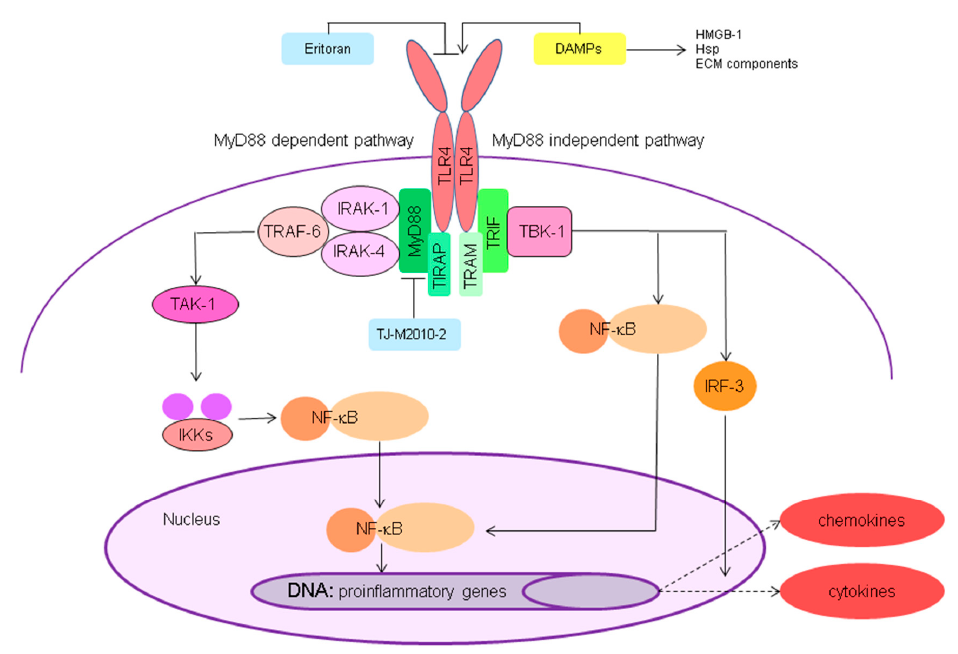
Figure 6. Toll-like receptor 4 signalling. Activation of toll-like receptor 4 (TLR4) by danger associated molecular patterns (DAMPs), like high mobility group box-1 (HMGB-1), heat shock proteins (hsp) and extracellular matrix (ECM) components, leads to downstream signalling via the MyD88 (Myeloid di ff erentiation primary-response protein 88) dependent and MyD88 independent pathway. The MyD88-dependent pathway in which MyD88 and TIRAP (toll-interleukin 1 receptor (TIR) domain containing adaptor protein) or MyD88 adapter-like (Mal) recruits and activates members of the IL-1 receptor-associated kinase (IRAK) family is considered to be the dominant pathway. IRAK activation leads to recruitment of TRAF6 (TNF receptor-associated factor 6) and subsequently activation of transforming growth factor beta-activated kinase 1 (TAK1). Activation of TAK1 then